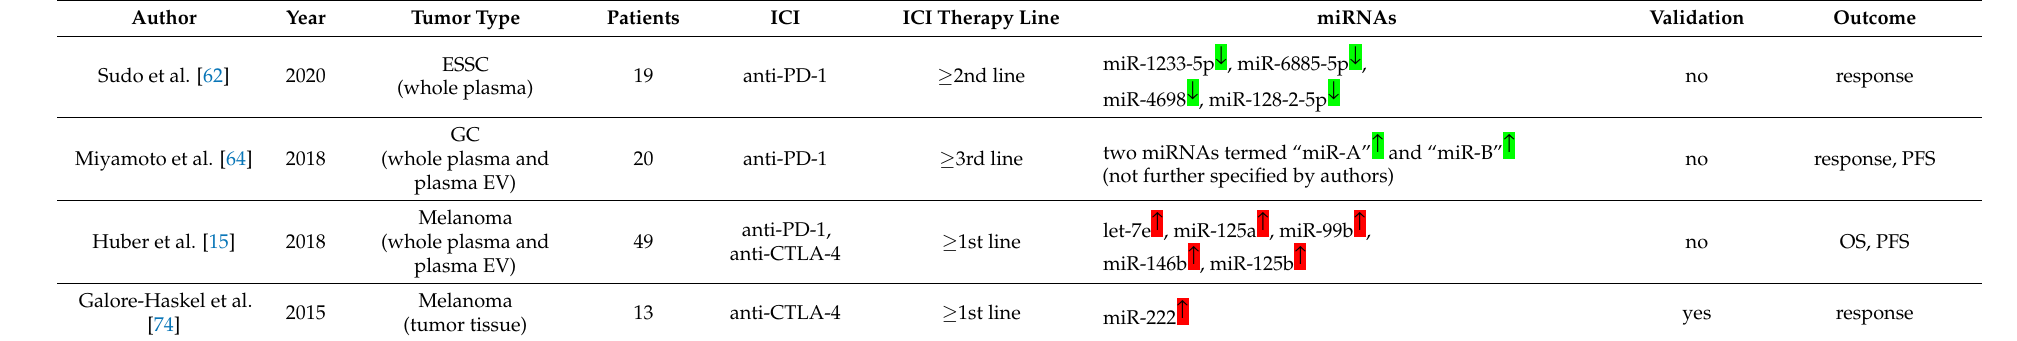
CTLA-4: cytotoxic T-lymphocyte protein 4, ESSC: esophageal squamous-cell carcinoma, EV: extracellular vesicles, GC: gastric cancer, ICI: immune-checkpoint inhibitor, MSC: microRNA signature classifier, NA: not available, NSCLC: non-small cell lung cancer, OS: overall survival, PFS: progression-free survival, PD-1: programmed cell death protein 1, PD-L1: programmed death ligand 1. Arrows indicate miRNA expression levels, and color code depicts associated clinical outcomes (green: better clinical outcome, red: worse clinical